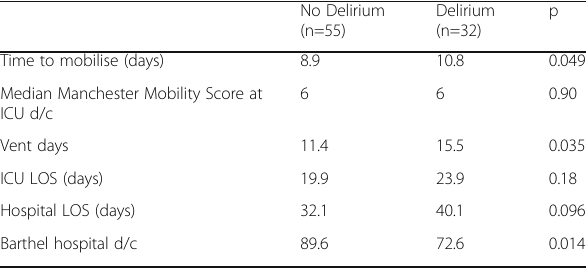
Table 2 (abstract 0376). Outcomes